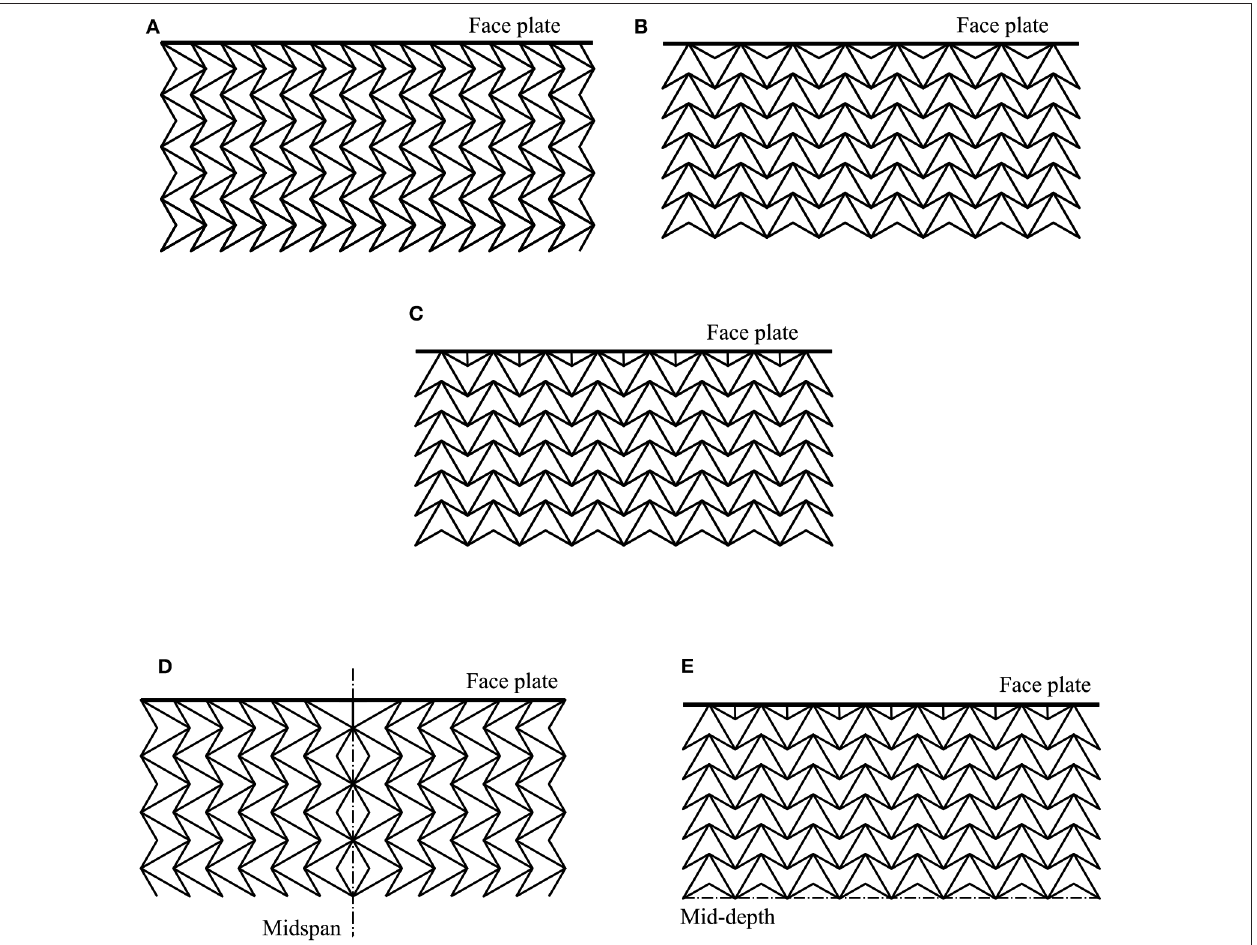
FIGURE 7 | Lattice cores with uniform geometries: (A) case AH: “Arrowhead Horizontal”; (B) case AV: “Arrowhead Vertical”; (C) case AV VS : “Arrowhead Vertical with Vertical Struts” at the face plates. Lattice cores with disruptions: (D) AHBF MS : horizontal arrows with back facing cells along the midspan line of symmetry and (E) AVBF VS : vertical arrows with back facing cells along the mid-depth line of symmetry. Note that only a portion of the panels are